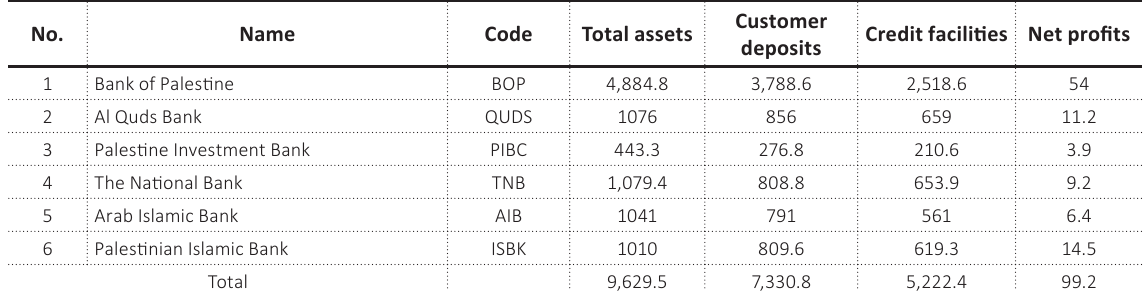
Table 1. Financial position of listed banks (million USD)